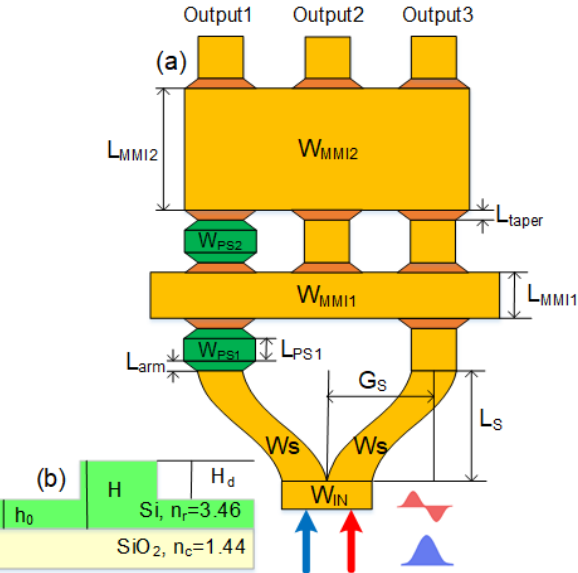
Figure 1. The schematic diagram of the proposed mode switch: (a) top view ; (b) side view. beam propagation method (BPM) and e ff ective